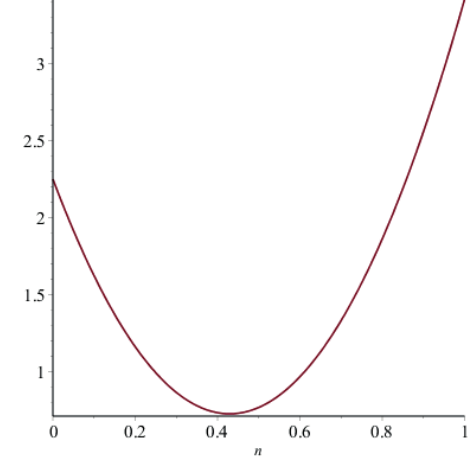
Figure 20: Plot of SSD ( D